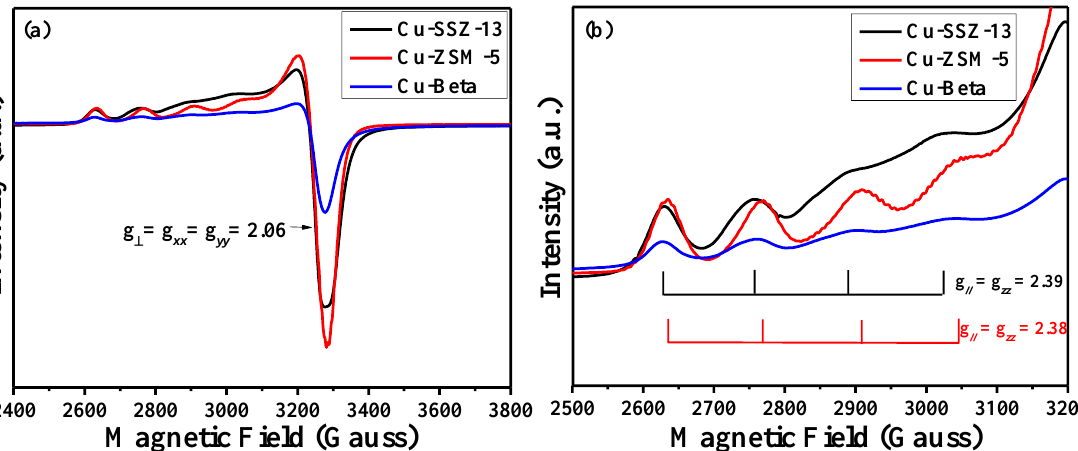
Figure 5. EPR spectra recorded at 110 K ( a ) and magnification of the low-field hyperfine structure ( b ) for the copper-based zeolites.